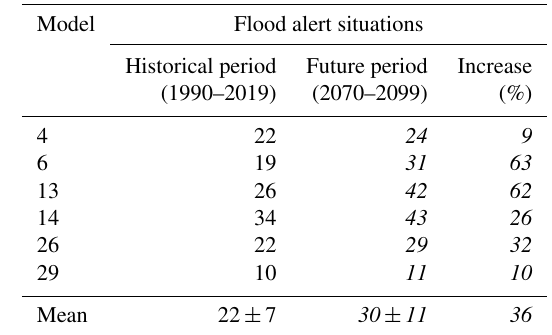
Figure 6. Percentage change in the frequency of river flow ranges in the future with respect to the historical period considering the average of valid models (multi-model). The river flow data were distributed in ranges of 200m 3 s − 1 . Each value of the river discharge indicates the mean of the corresponding range (100m 3 s − 1 corresponds to the range of 0–200m 3 s − 1 ). In the last range (2100m 3 s − 1 ), the river flows surpassing the alert threshold (2000m 3 s − 1 ) are included. Positive (negative) values indicate in- crease (decrease) in the future. Black bars represent the multi-model deviation.